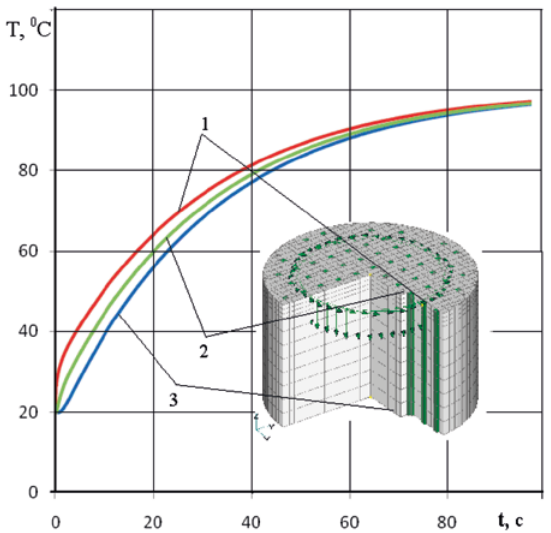
Fig. 3. Temperature distribution for the discrete surface of a sample depending on time: 1 – temperature change in the area between dimples; 2 – temperature change in the dimple; 3 – temperature change at the base of the sample On discrete areas in the form of cavities or dimples, a complex fluid motion is formed, depending on the mode of flow and geometric parameters of the surface.